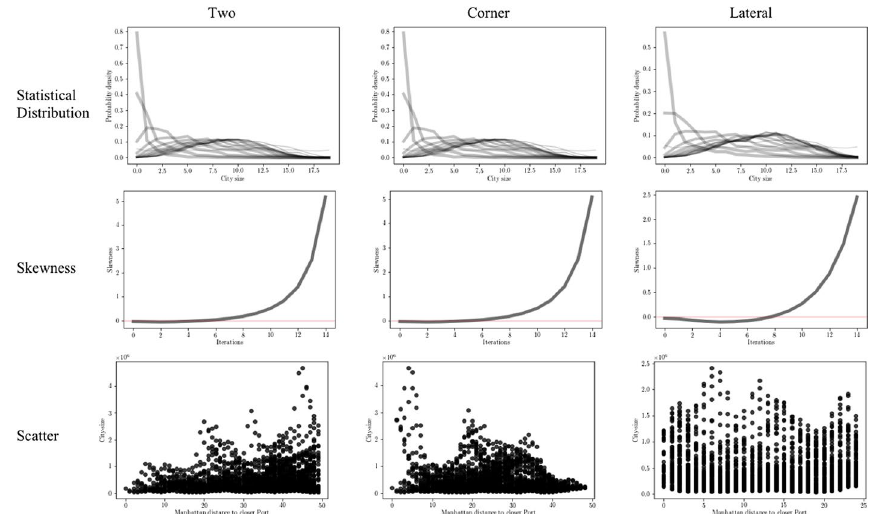
Fig. 7 Port configurations. Dynamics of the statistical distributions, skewness, and correlations. The skewness was computed by the Fisher‑Pearson coefficient scipy.stats.skew. Each value of skewness is associated with each curve of statistical distribution per case. Scatter plots: (x‑axis y‑axis city‑size) =